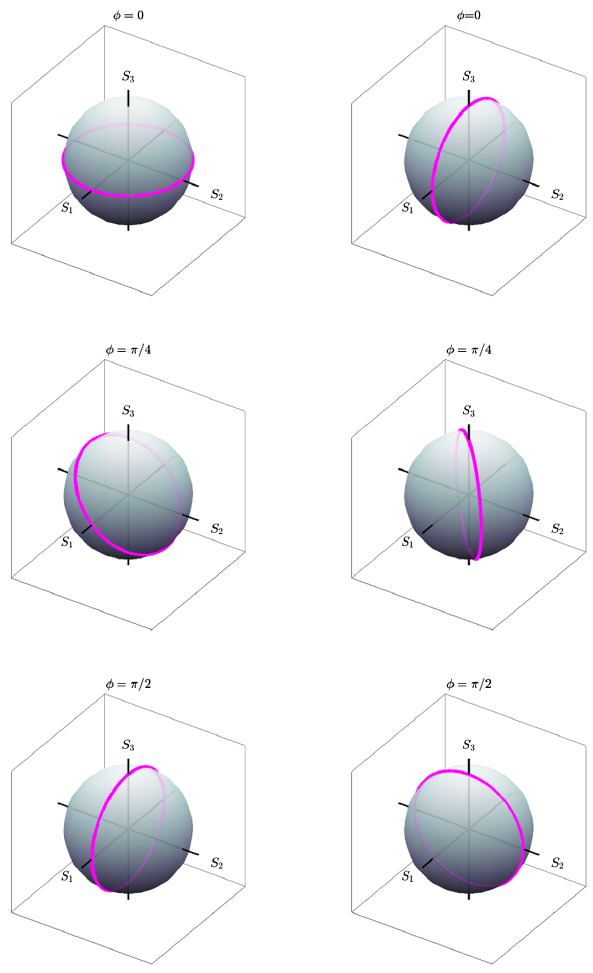
FIG. 3. Distribution of Stokes parameters on the Poincar´e sphere for two-color emission with crossed linear undulators (left) and crossed helical undulators (right). The time delay is Δ t ¼ π = Δ ω